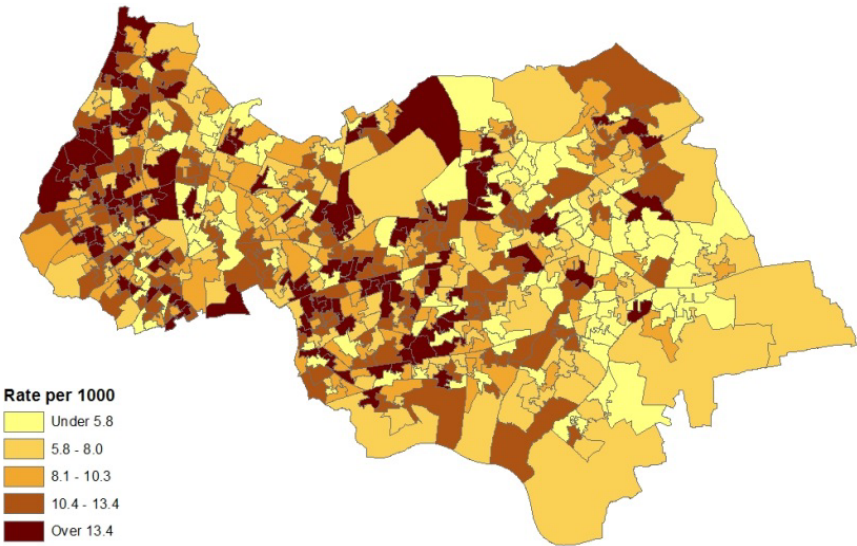
Figure 1. Asthma hospitalisations, rates per 1,000, LSOAs, outer NE